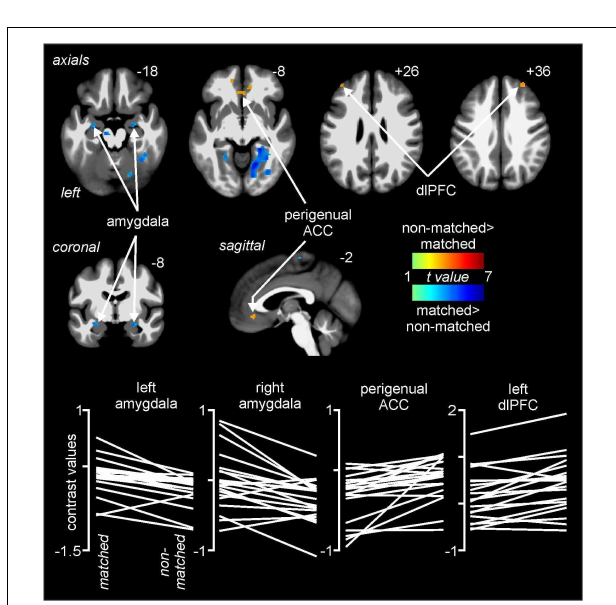
FIGURE 4 | Differences in signal intensity changes with painful stimuli during non-matched compared with matched expectation scans using wholebrain images. Greater signal intensity increases (hot color scale) occurred during the non-matched compared with matched scans in the region of the perigenual anterior cingulate cortex (ACC) and the dorsolateral prefrontal cortex (dlPFC) bilaterally. Reduced signal intensity increases (cool color scale) occurred in the non-matched expectation scans in the amygdala bilaterally. Slice locations in Montreal Neurological Institute space are indicated at the top right of each image. The lower row are plots of contrast values for the left and right amygdala, perigenual ACC, and left dlPFC for each subject during matched and non-matched expectation